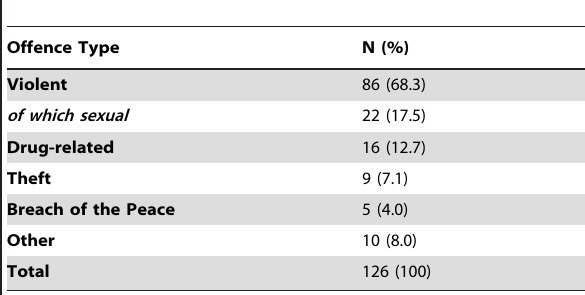
Table 4. Self-reported index